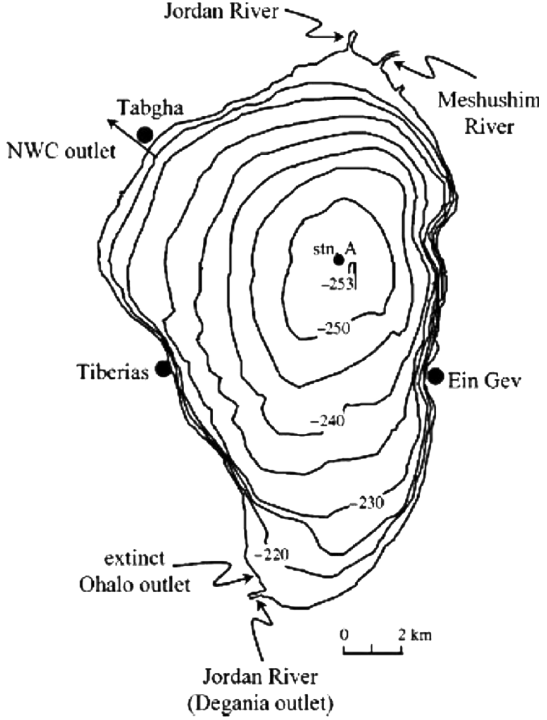
Figure 1. Map of Lake Kinneret, located in the north of Israel. Numbers correspond to altitude measured in meters from the level of Lake Kinneret. Cores were taken from station A (taken from Hambright et al.,